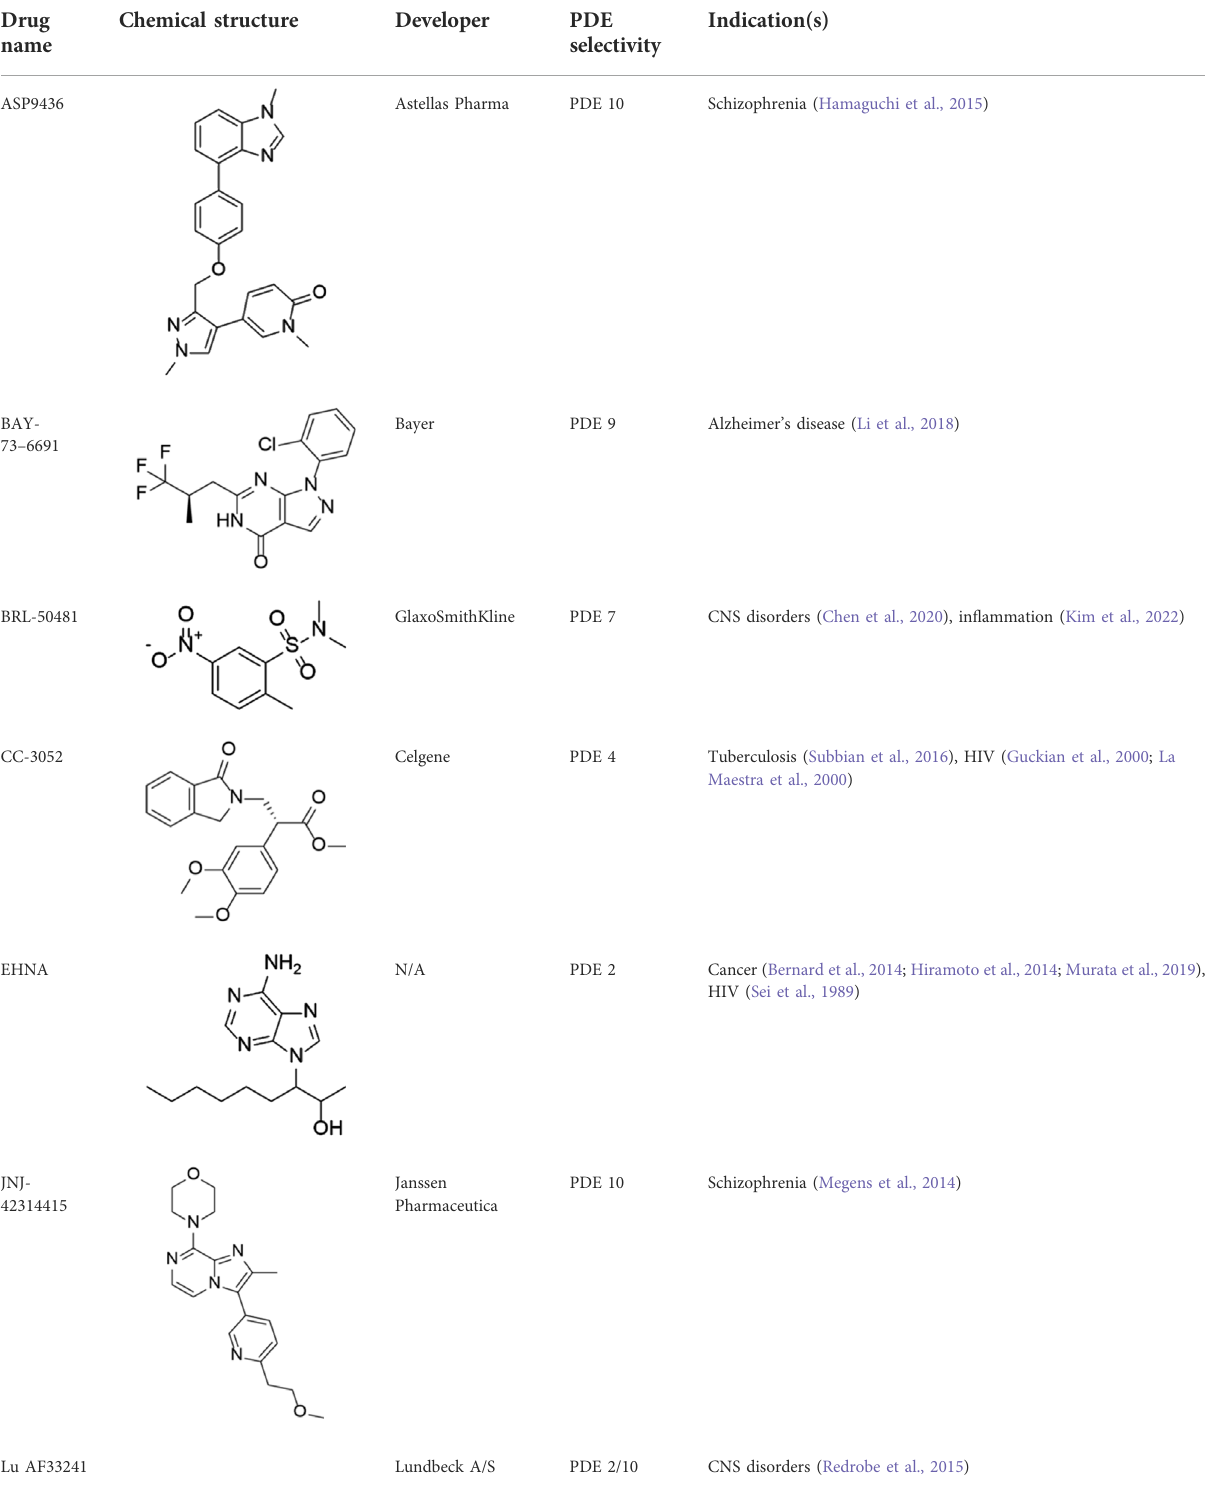
TABLE 7 Selected experimental PDE inhibitors. This table provides a summary on some of the experimental PDE inhibitors in pre-clinical studies. The aggregated data on studies is listed as per the PubMed database. Chemical structures are derived from the PubChem database (Kim et al., 2021). Developer names are listed according to the relevant